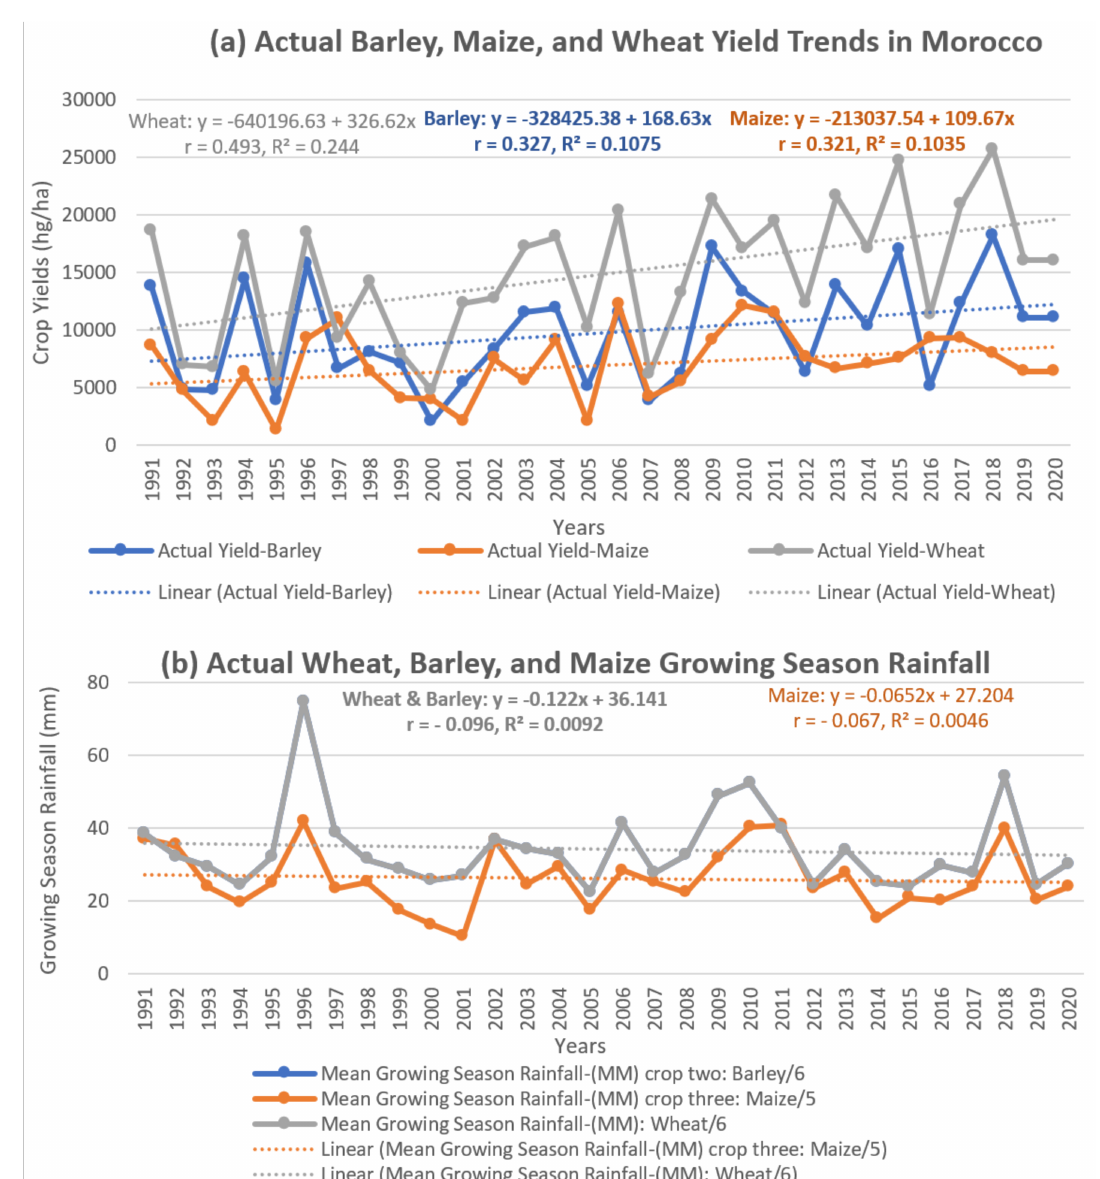
Figure 4. Trends in ( a ) actual wheat, barley, and maize yields, and ( b ) actual mean growing season precipitation for wheat, barley, and maize in